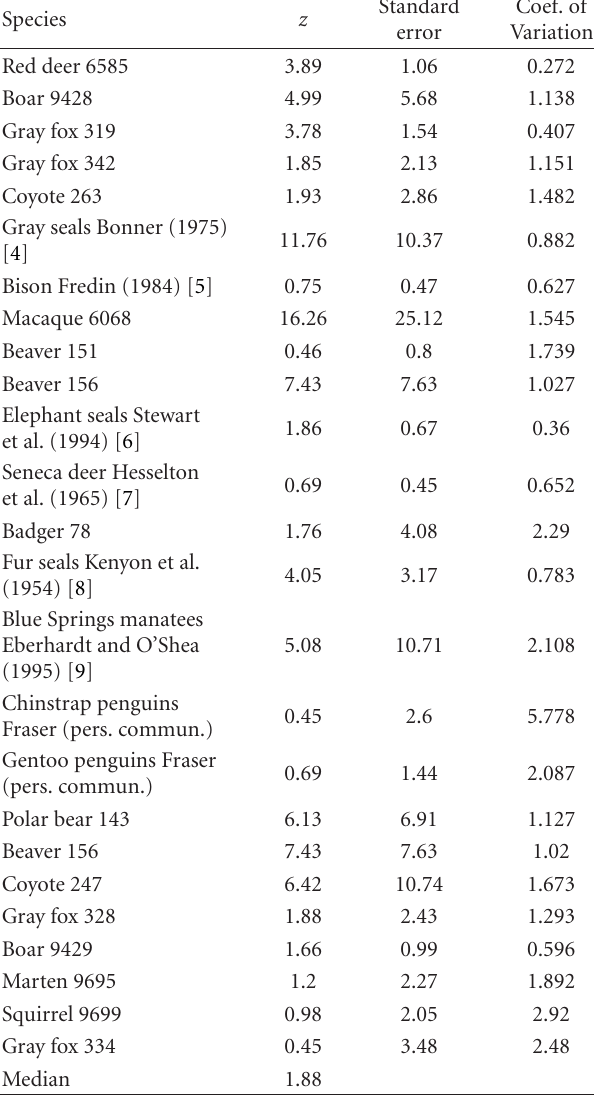
Table 1: Estimates of the parameter z in (1).